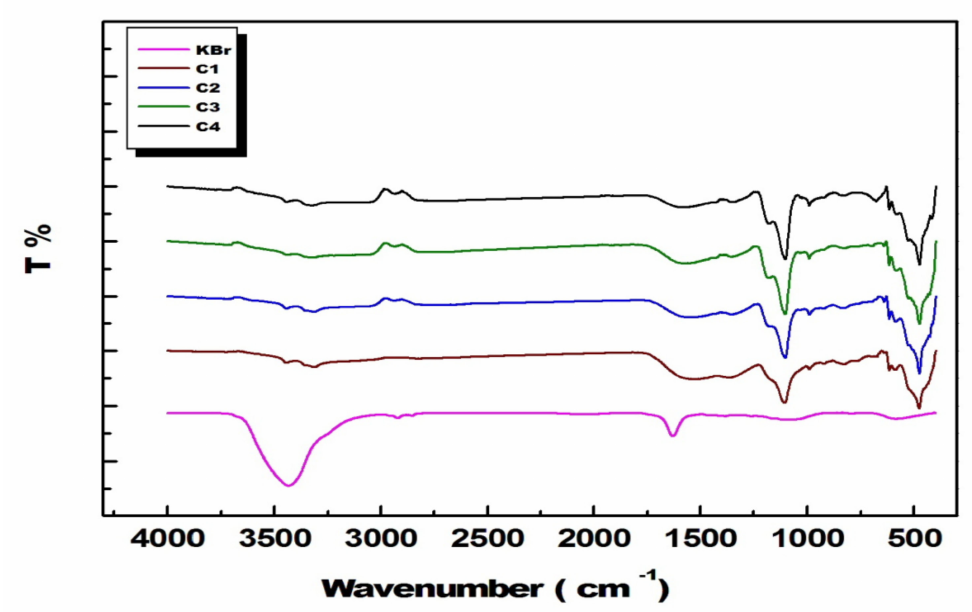
Figure 3. Fourier-transform infrared (FTIR) spectrum of the C1, C2, C3, and C4 samples. The presence of the C element is due to the use of egg white in the synthesis